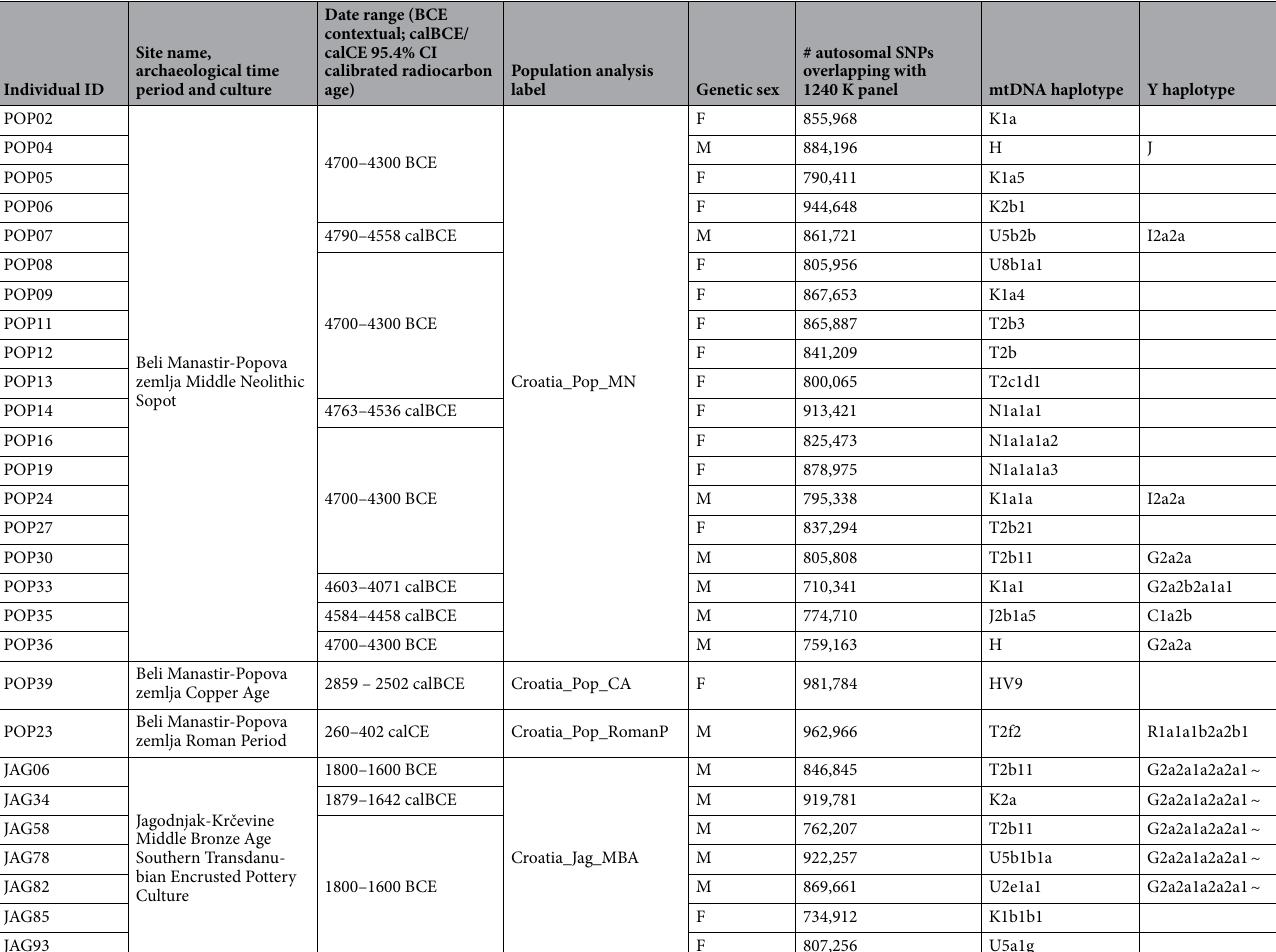
(Table 1, Supplementary Fig. S1, Supplementary Table S1). We merged the data from the newly reported indi- viduals with a published worldwide dataset of 1311 present-day individuals genotyped on the Human Origins (HO) array 30 (Methods), and data from 1102 published ancient individuals (Methods, Supplementary Table S2) after filtering for contaminated samples and first-degree relatives. All passing individuals had at least 700,000 SNPs available for downstream analyses (Table 1). Genetic transformations from the Neolithic to Roman times. In order to understand the genetic affinities of the samples, we performed principal components analysis (PCA) (Methods) by projecting the new shotgun data and published ancient datasets onto the first two principal components constructed from 920 indi- viduals selected from contemporary West Eurasian populations in the Human Origins (HO) dataset 30 (Meth- ods, Fig. 2). We also performed model-based clustering analysis in an unsupervised mode with ADMIXTURE (Methods) using 1311 present-day individuals taken from a panel of worldwide populations (Supplementary Fig. S2). The newly-reported individuals fall along the European cline in PCA space, extending between Neolithic agriculturalist and Bronze Age pastoralist populations. Croatia_Pop_MN clusters tightly with other southeast and central European Neolithic and Copper Age individuals, including Copper Age Croatians from Radovanci and Vučedol, who were merged for further analysis into Croatia_North-East_CA, and share similar ADMIXTURE profiles that exhibit a major contribution from Anatolia-related ancestry (Anatolia_N) and a small contribu- tion of Western European hunter-gatherer (WHG)-related ancestry (Supplementary Fig. S2). We also merged Croatia_Pop_MN and Croatia_Osijek_MN to form Croatia_North-East_MN for further analysis, before testing shared drift with other ancient and modern West Eurasian populations with outgroup f 3 -statistics of the form f 3 (Croatia_North-East_MN, Test; Mbuti.DG) (Supplementary Fig. S3a-b, Supplementary Table S3, Methods).